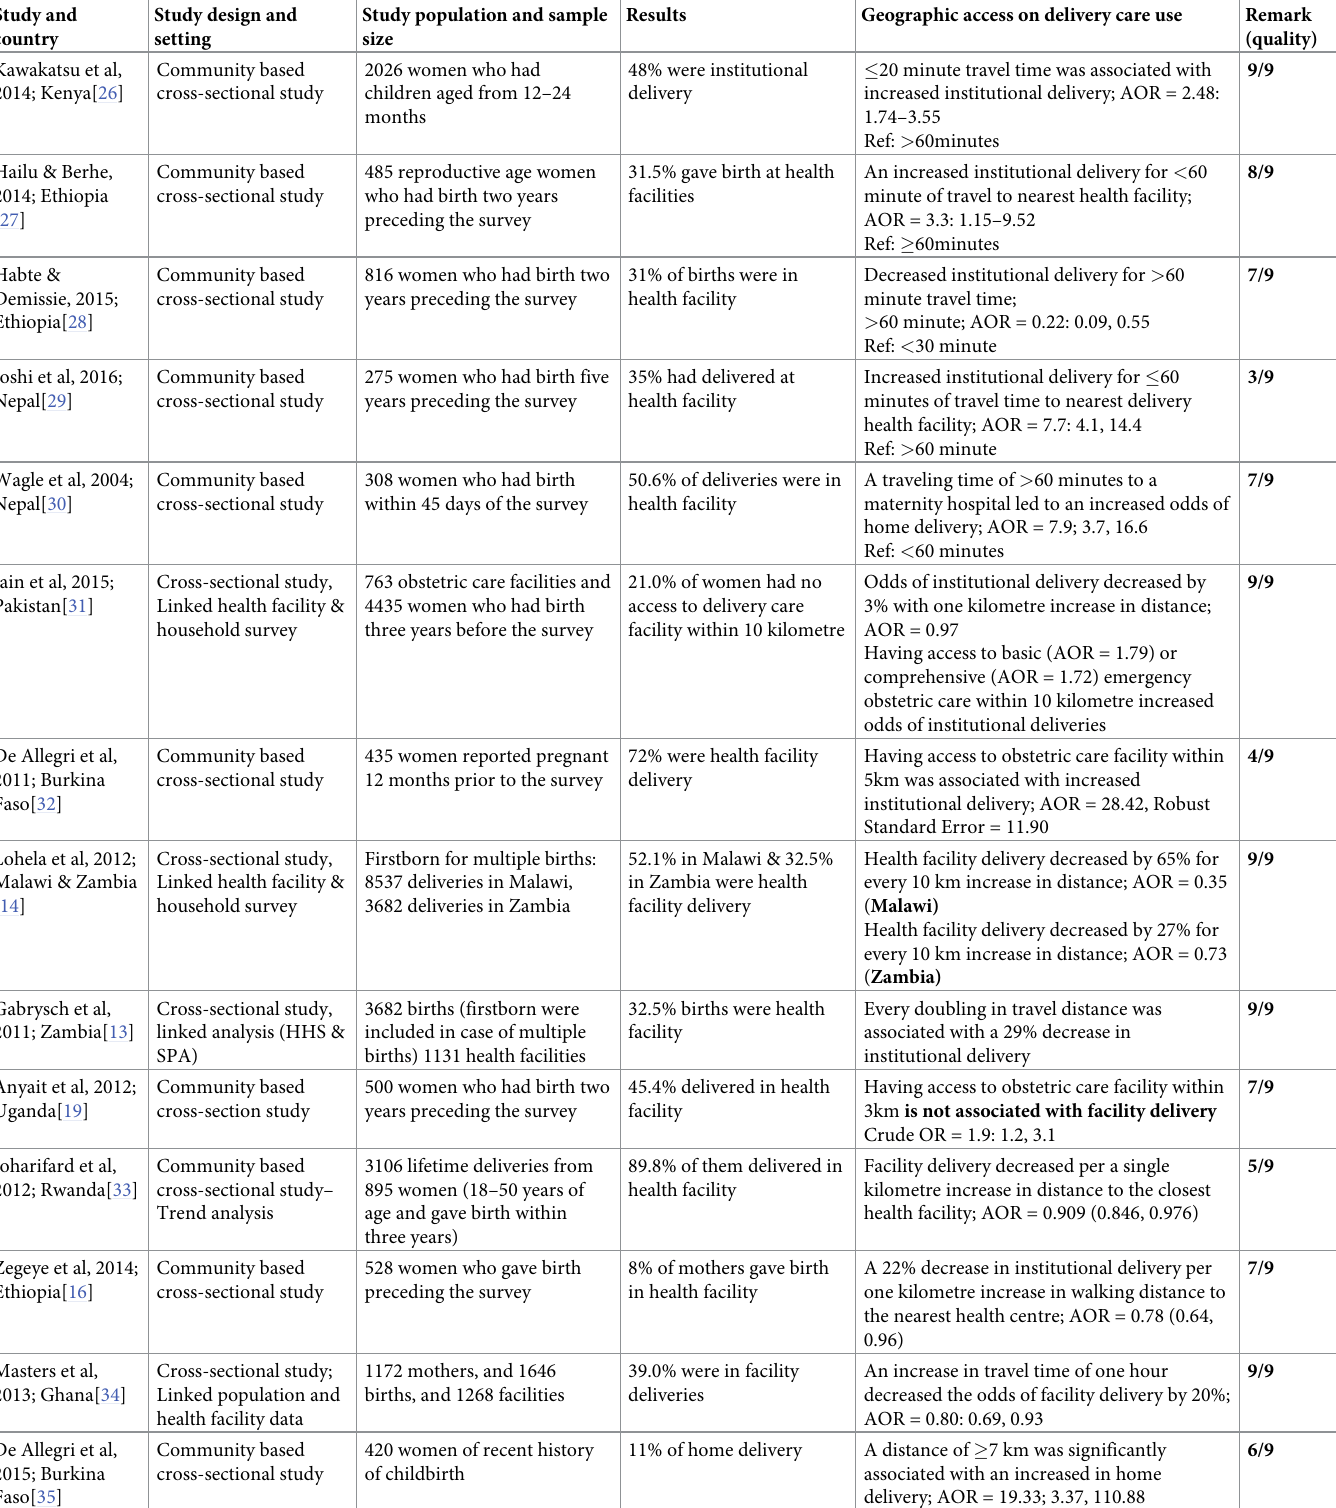
Table 1. Summary table for studies included in the systematic review and